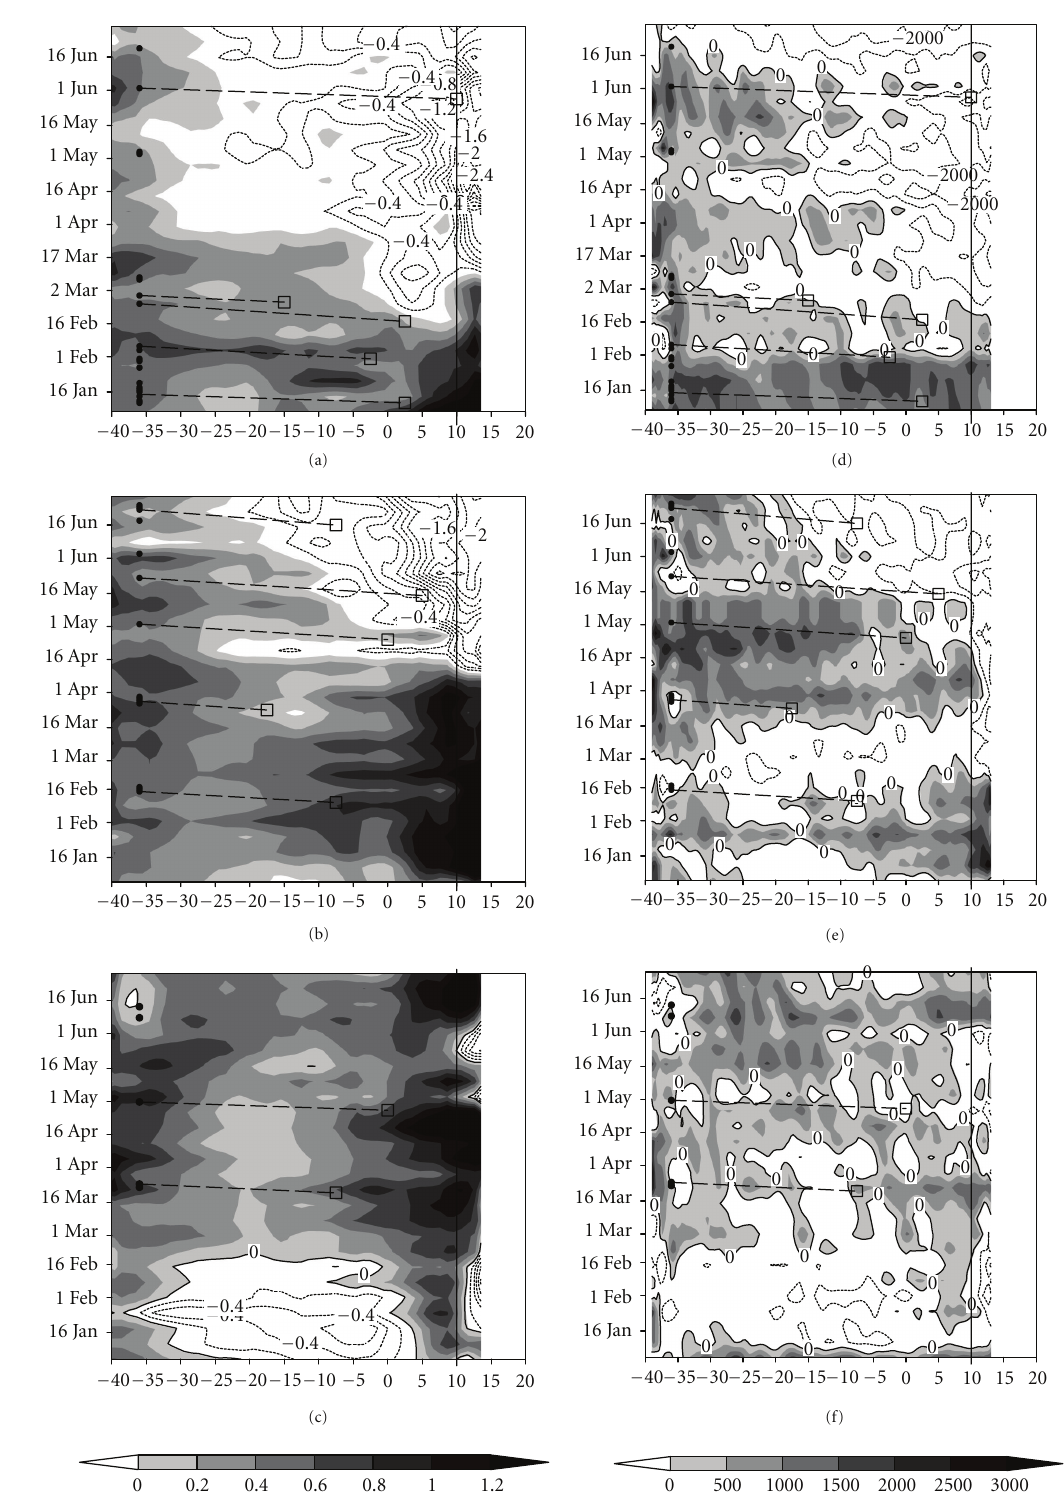
Figure 14: Time-longitude SST anomaly ((a), (b), (c)) ( ◦ C) and HC anomaly ((d), (e), (f)) (KJ · cm − 2 ) averaged over 2.5 ◦ S–12.5 ◦ S for the periods January–June of 2004 (top), 2005 (middle), and 2006 (bottom). Positive values are shaded. The horizontal signatures of the twelve selected EW events are shown by dashed